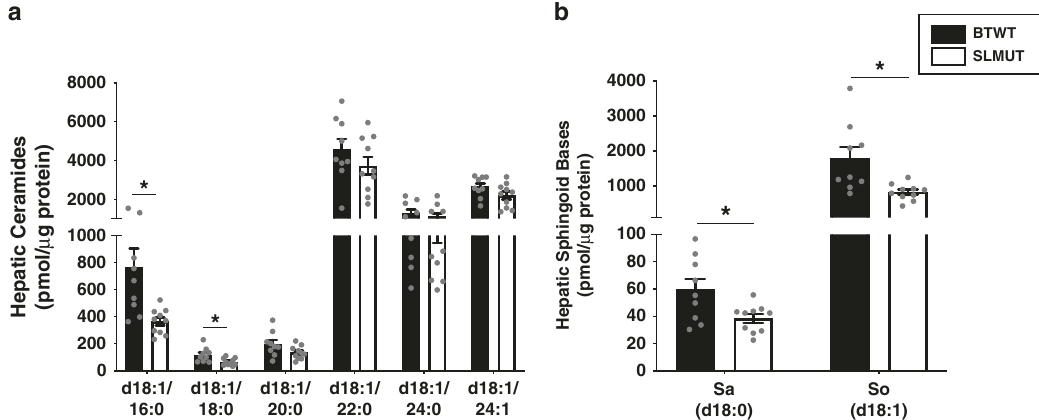
Fig. 5 Increased hepatic ceramides in mice supplemented with BTWT as compared with SLMUT. Bar charts represent mean SL abundance ± SEM for ( a ) Hepatic ceramides and ( b ) hepatic sphingoid bases of BTWT treated (black bars) and SLMUT treated (white bars) mice. a , b Observations with signi fi cant differences in SL abundance are marked with stars SLMUT (two-sided t -test, * p < 0.05). For BTWT n = 9 and for SLMUT n = 10. Source data are provided as a source data fi le. For all fi gures with bars, height of bar = mean and error bar is dihydroceramide (d18:0/18:1) (Supplementary Fig. 8a) relative to the SLMUT-mice; sphingomyelins were equivalent (Supplemen- tary Fig. 8b). These results are consistent with fi ndings that oral